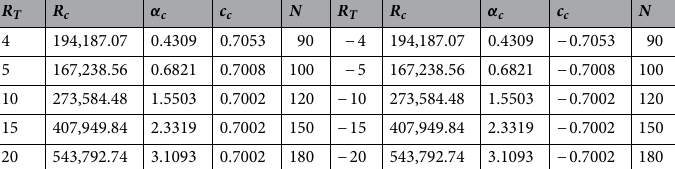
Table 3. Values of critical triplets ( R c , α c , c c ) for different values of R T